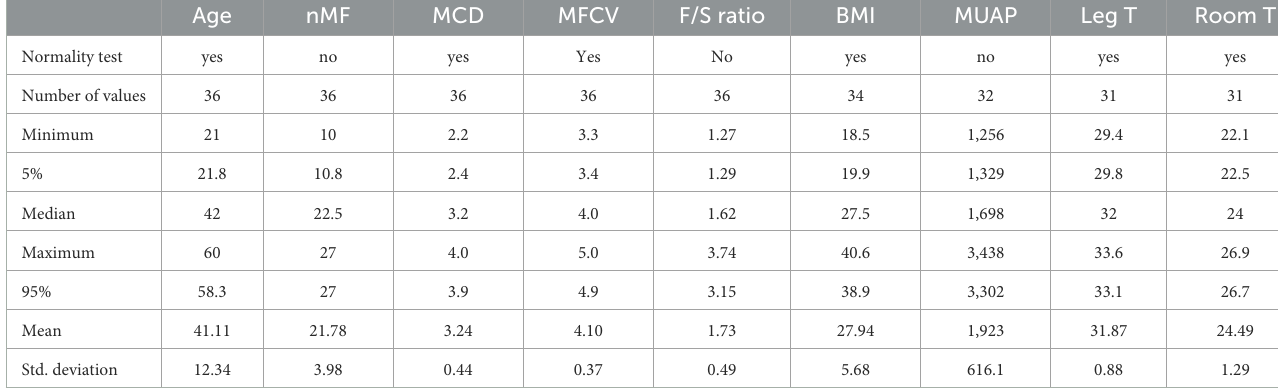
TABLE 1 Mean or median from nine variables from the 36 subjects, 18 female subjects and 18 male subjects. Age nMF MCD MFCV F/S ratio BMI MUAP Leg T Room T Normality test